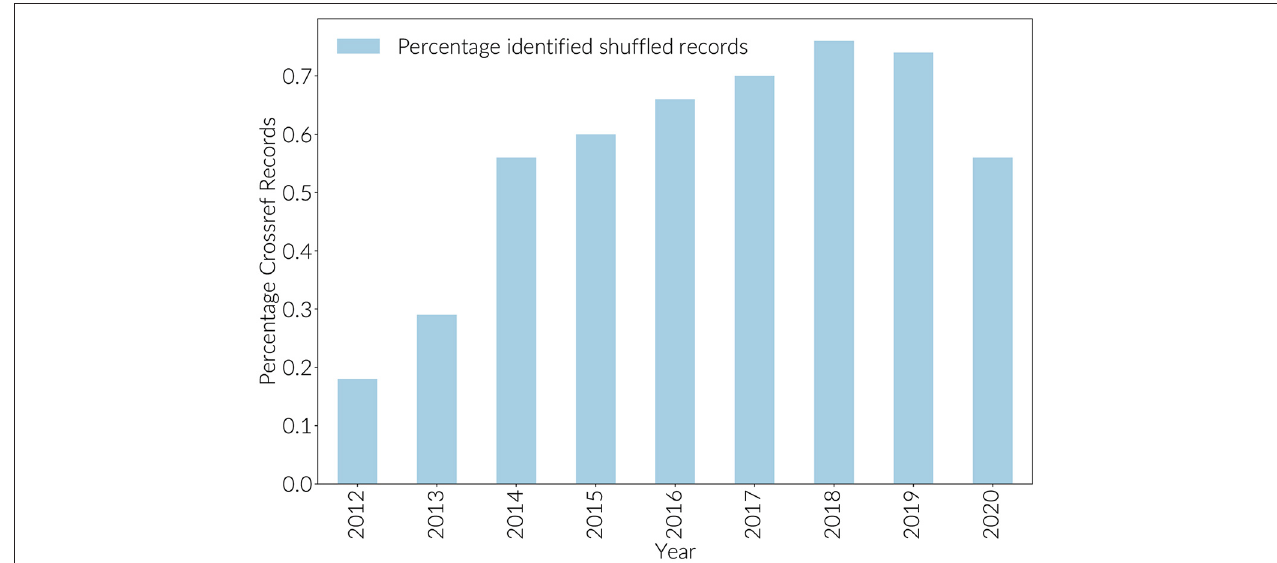
FIGURE 1 | Percentage identified shuffled ORCID